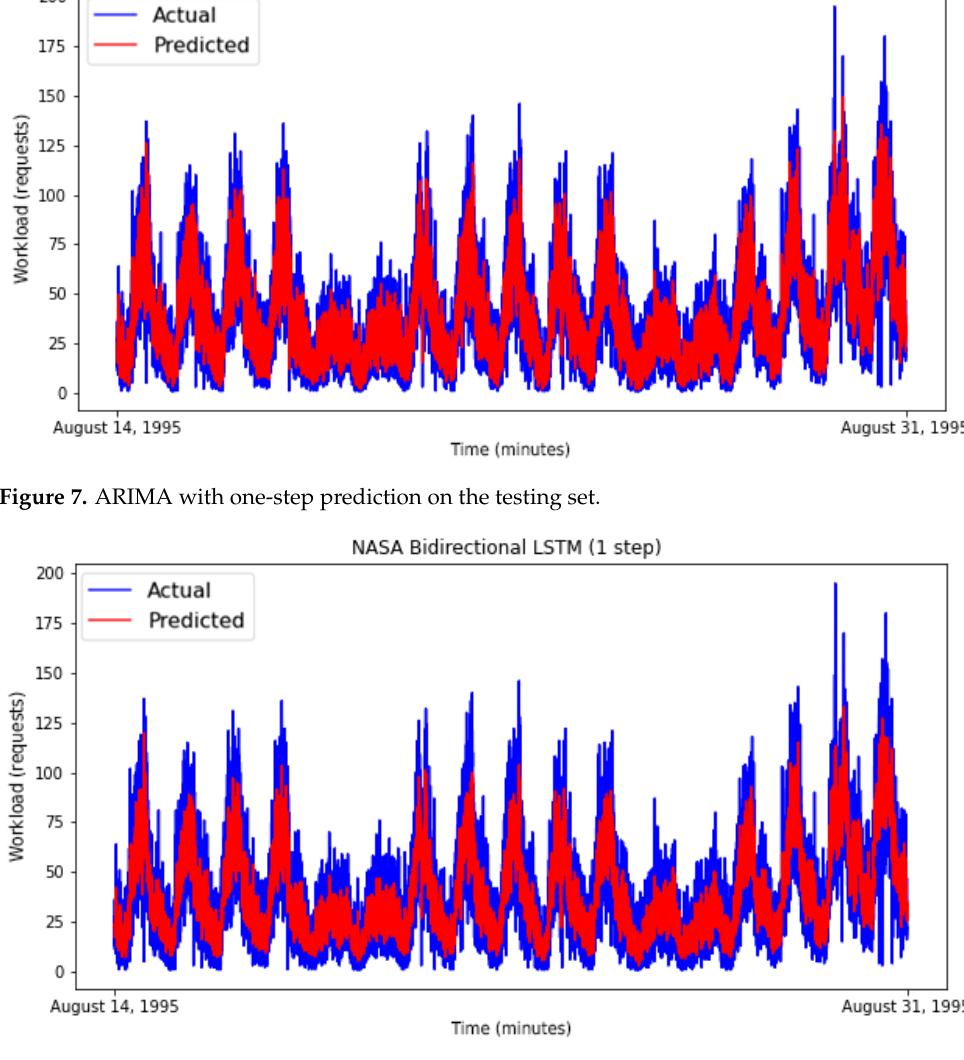
Figure 8. Bi-LSTM with one-step prediction on the testing set.